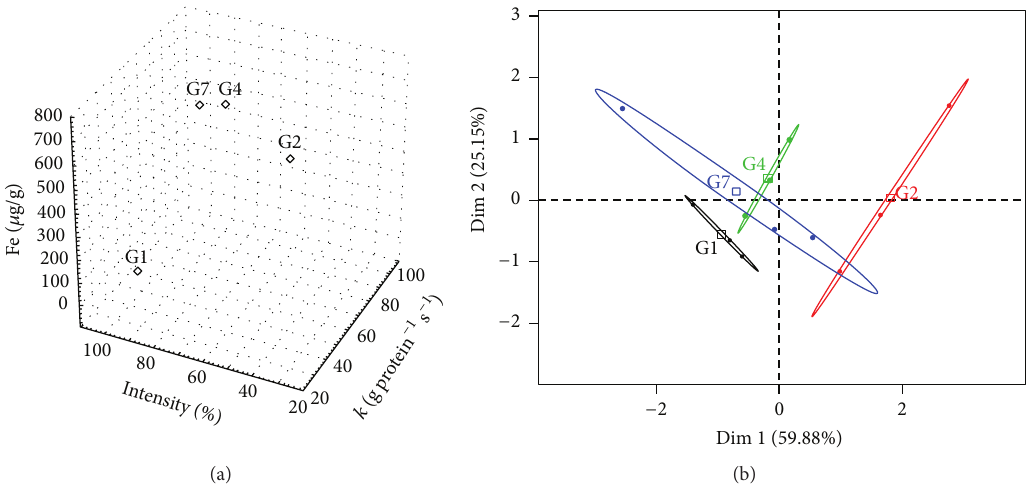
Figure 2: (a) Relation among the three studied variables: iron concentration ( 𝜇 g ⋅ g −1 ), catalase activity ( 𝑘 , s −1 ⋅ g protein −1 ), and band intensity percentage (%). (b)Principal component analysis (PCA). Thefirst ( 𝑥 -axis)was able to explain about 60% of thetotal variability and thesecond ( 𝑦 axis) was able to explain about 25% with the ellipses of 95% confidence limits, constructed by bootstrap resampling, using replicates of the original